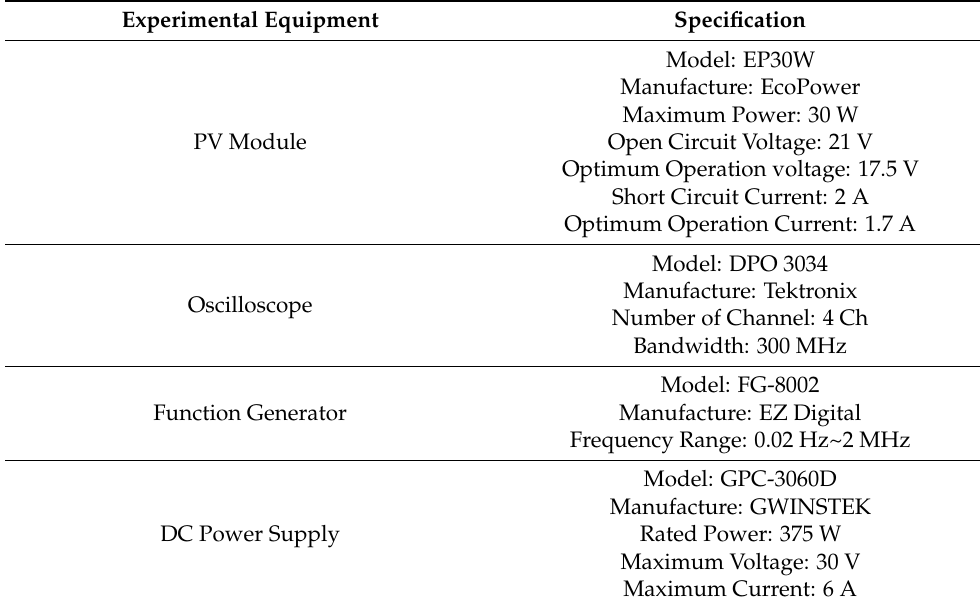
Table 3. The experimental equipment’s specifications.